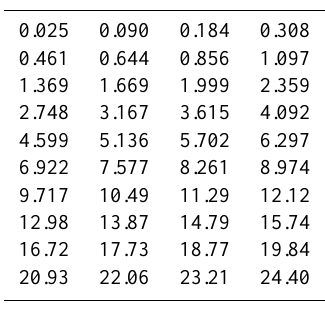
Table A1. Vertical grid mesh